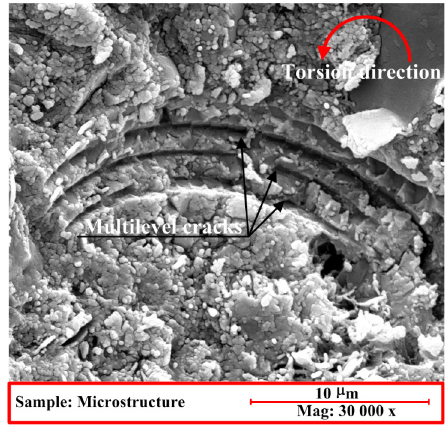
Fig. 6. A view of fractured specimen after the fracture toughness test, showing the failure surface